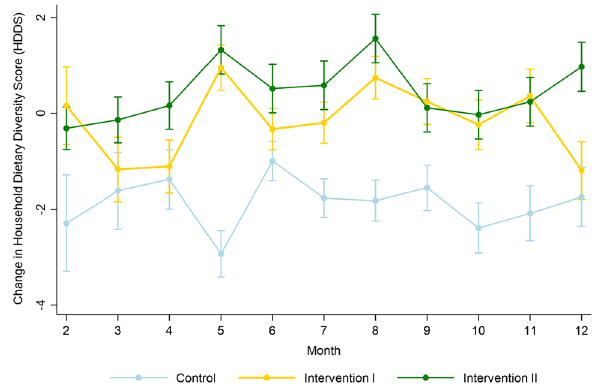
Figure 4. Estimated change in the Households Dietary Diversity Scores (HDDS) (with 95% confidence interval) by treatment groups over a 12-month observation